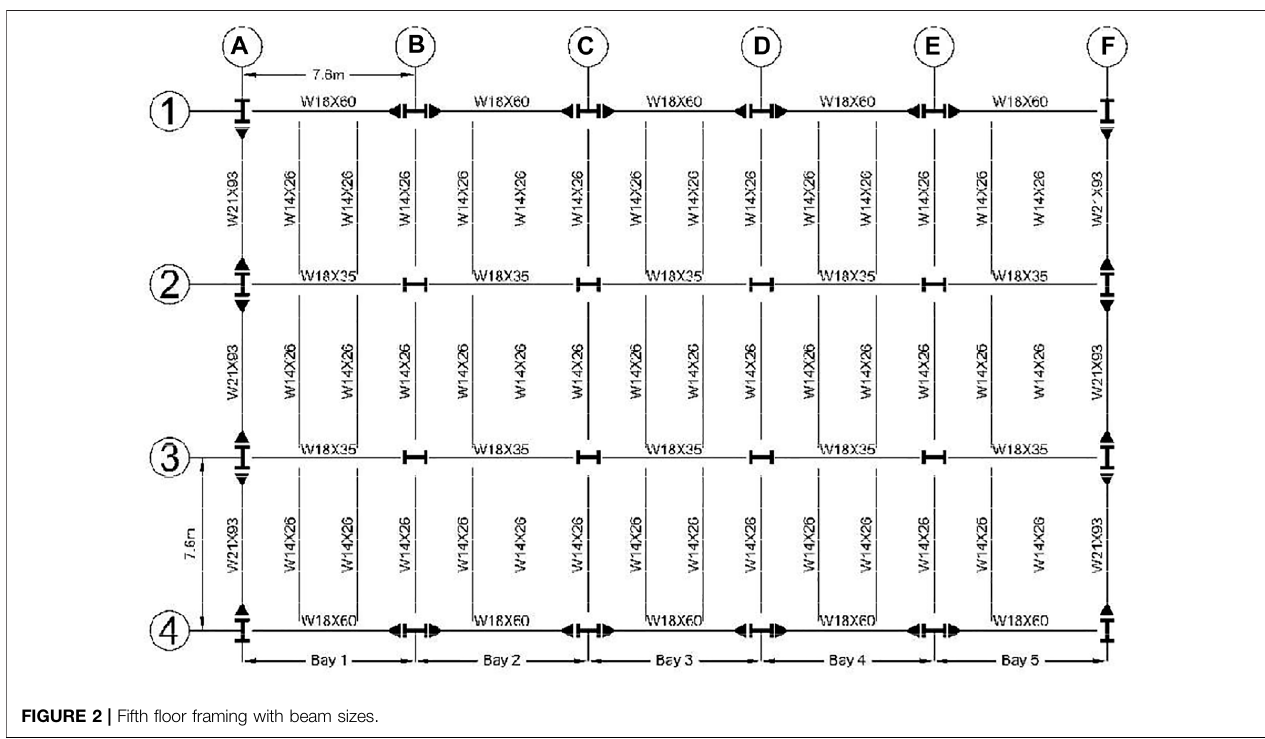
FIGURE 2 | Fifth fl oor framing with beam sizes.